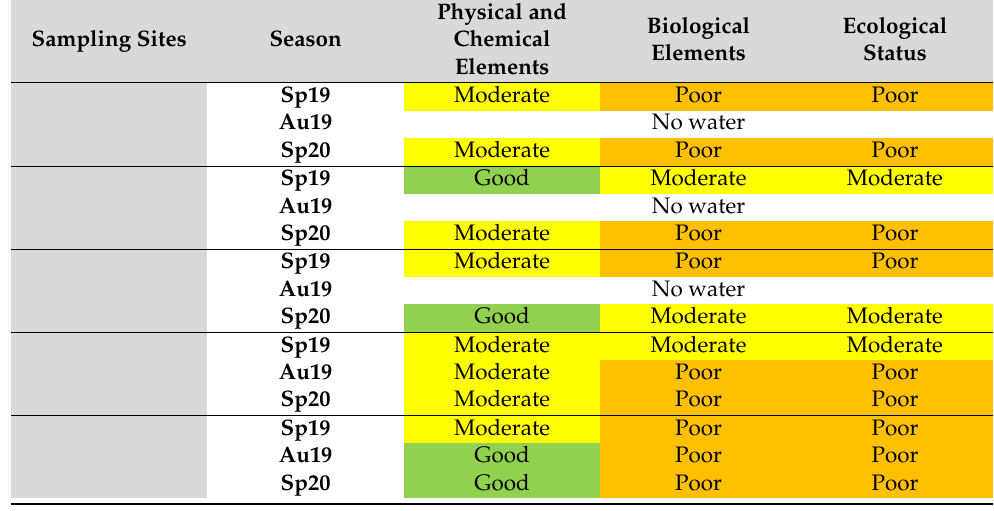
Table 4. Classification of physical and chemical elements; biological quality elements (benthic macroinvertebrates) and determination of the ecological status of each sampling point in the three sampling periods, according to the WFD classes (different colors excellent, good , moderate , poor , bad). The ecological status is determined based on the element with the worst classification between the elements of general physical and chemical quality and the elements of biological